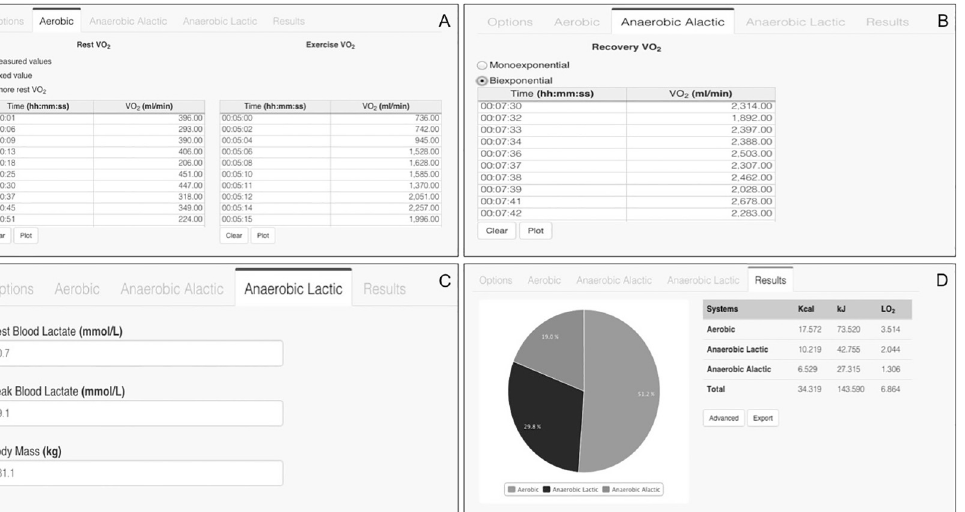
Fig 1. Templates of the GEDAE-LaB for input of physiological data. These templates are used to calculate aerobic (panel A), anaerobic alactic (panel B), and anaerobic lactic (panel C) systems contributions, as well as output data of energetic profile and energy expenditure amount (panel D) during severe